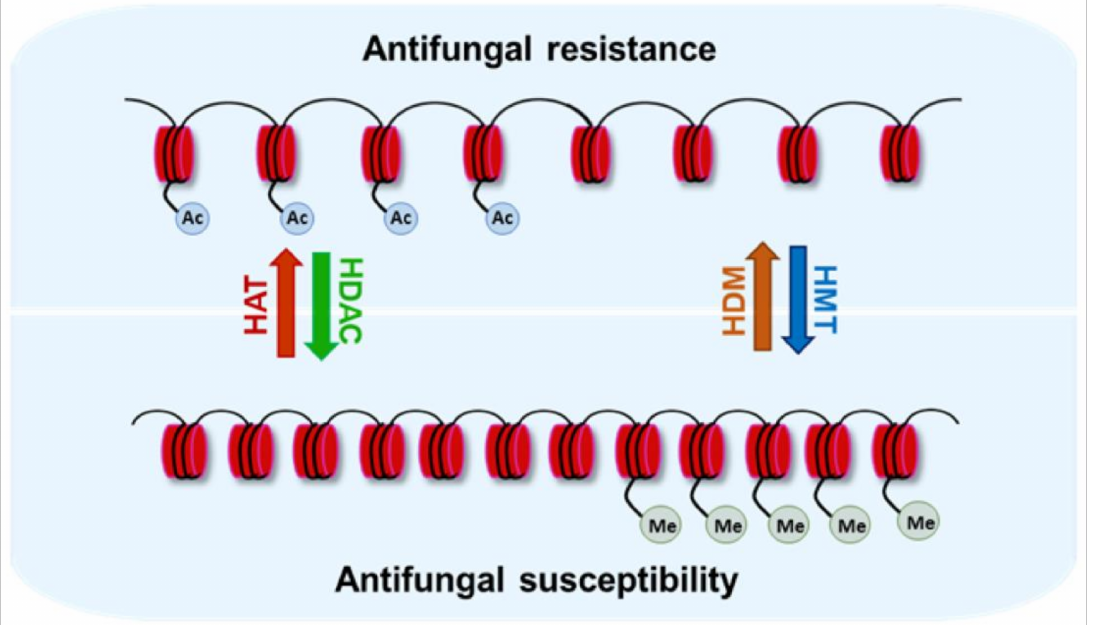
Figure 2. The effects of histone acetylation and methylation on resistance to antifungal drugs. Open and compact chromatin has been associated with decreased and increased drug susceptibility, respectively, in some